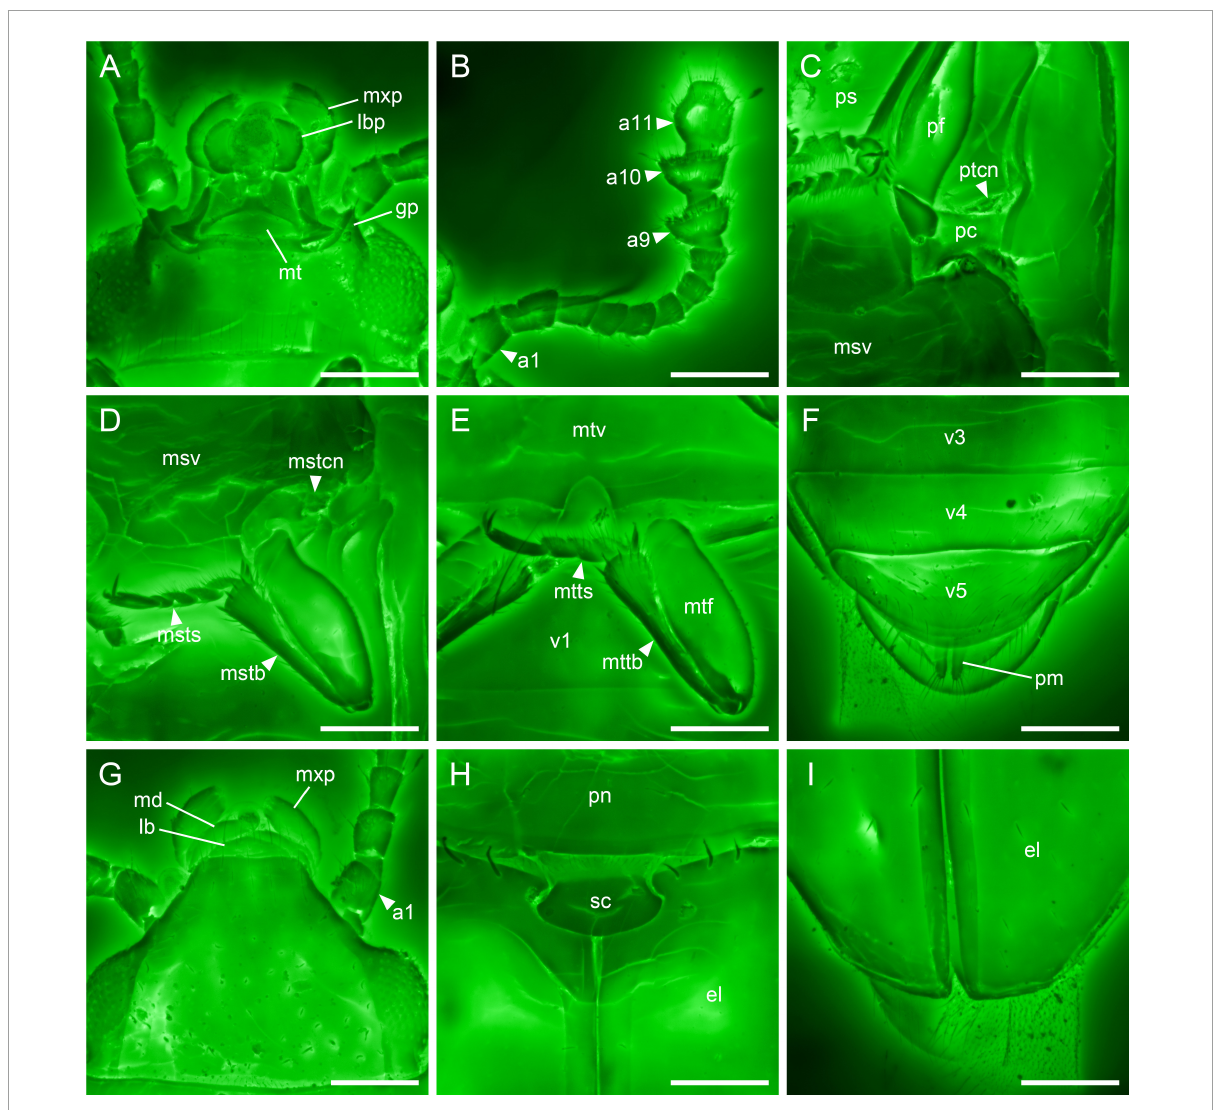
FIGURE3 Details of Alloterocucus atratus Li, Leschen Liu, and Cai gen. et sp. nov., holotype, NIGP180056, under confocal microscopy. (A) Head, ventral view. (B) Antenna, ventral view. (C) Prothorax, ventral view. (D) Mid leg, ventral view. (E) Hind leg, ventral view. (F) Abdominal apex, ventral view. (G) Head, dorsal view. (H) Scutellum, dorsal view. (I) Elytral apex, dorsal view. a1–11, antennomeres 1–11; el, elytron; gp, genal projection; lb, labrum; lbp, labial palp; md, mandible; mstb, mesotibia; mstcn, mesotrochantin; msts, mesotarsus; msv, mesoventrite; mt, mentum; mtf, metafemur; mttb, metatibia; mtts, metatarsus; mtv, metaventrite; mxp, maxillary palp; pc, procoxa, pf, profemur; pm, paramere; pn, pronotum; ps, prosternum; ptcn, protrochantin; sc, scutellum; v1–5, ventrites 1–5. Scale bars: 100 µ